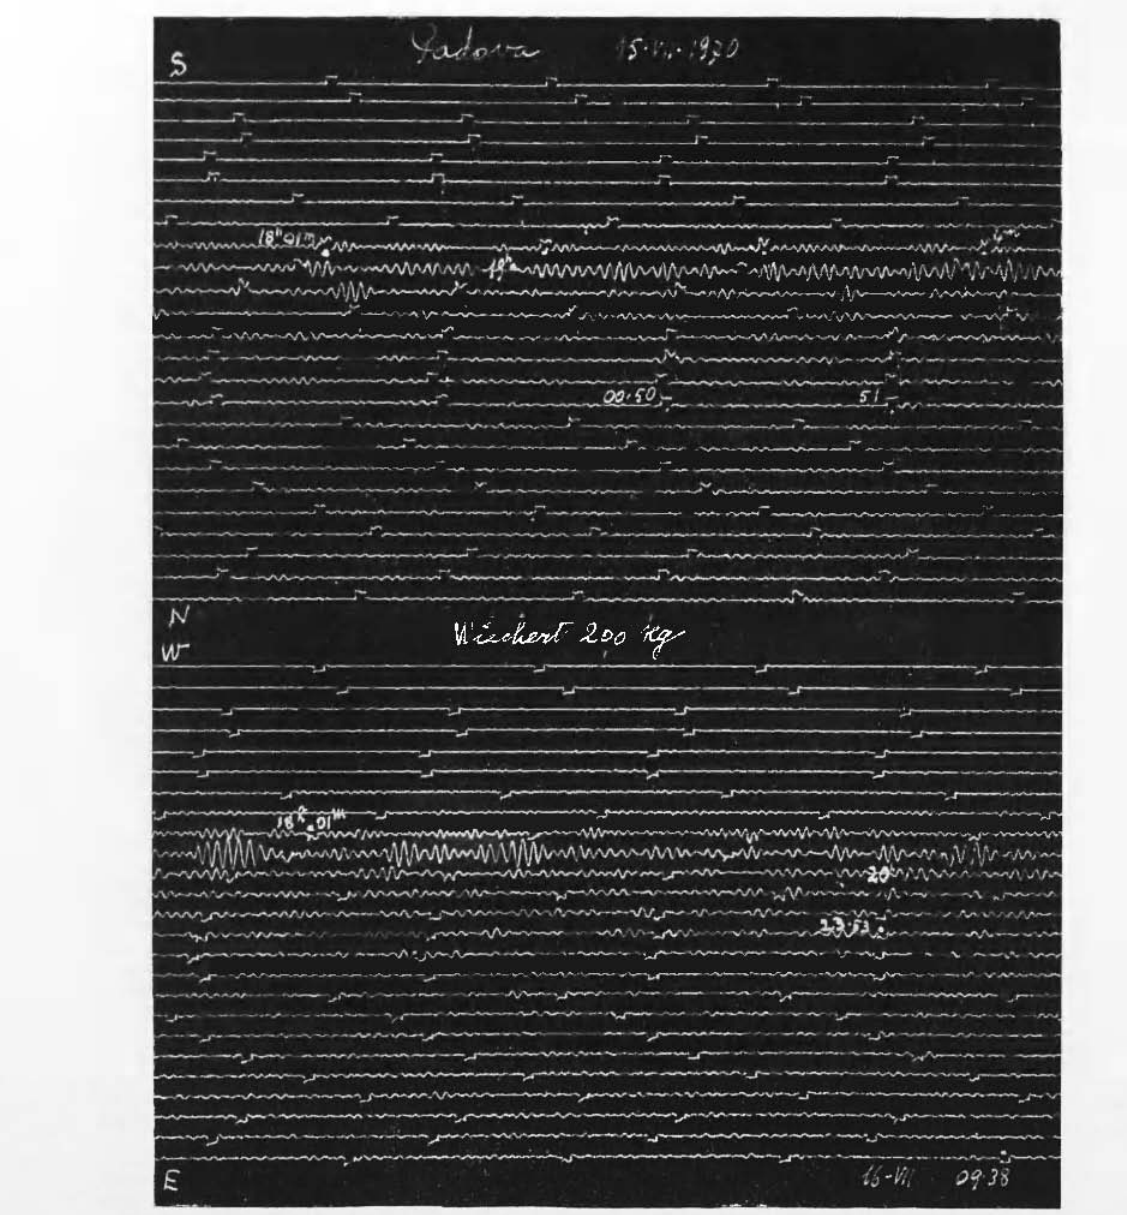
Fig. 21 Registrazione di microsismi, associati al t.ran~ito del ciclone dol 15.VII.1970 sulI'alto Adriatico, ottenuta a Padova, ad oltre 130 krn dalla zona-origine (golfo di Triesto). La Val l'adana tllialta questo ti}JO di oscillazioni. r miCTosismi registrati a Padova risultano infatti nettamente !liù ampli di quelli contemporaneamente ottonuti a Trieste, ai margini della zOlla-origine. Va precisato che il • Wiecllert» di Padova ha un ingrandimento pari a meno di lj5 di (plello del sismografo a lungo IHlriodo fun- zionanto a Trieste (fig. 19), !l{)l' periodi doll'ordine di 3 ~ec. Fig. 21 - Reeording Di microsoisms aMociated tu the }lll.ll:<age of tlHl cycloIle of July 15, 1970 over the High Adriatic Sea, takoll in Padova at OV6r 130 kms distance from the ori;in area (Gulf of Trieste). The Po Valley enhances this kind of oscillations. Tl){l mlCroseisms measureù in Paùova, in fact, are distinctly arnpler than tho8e